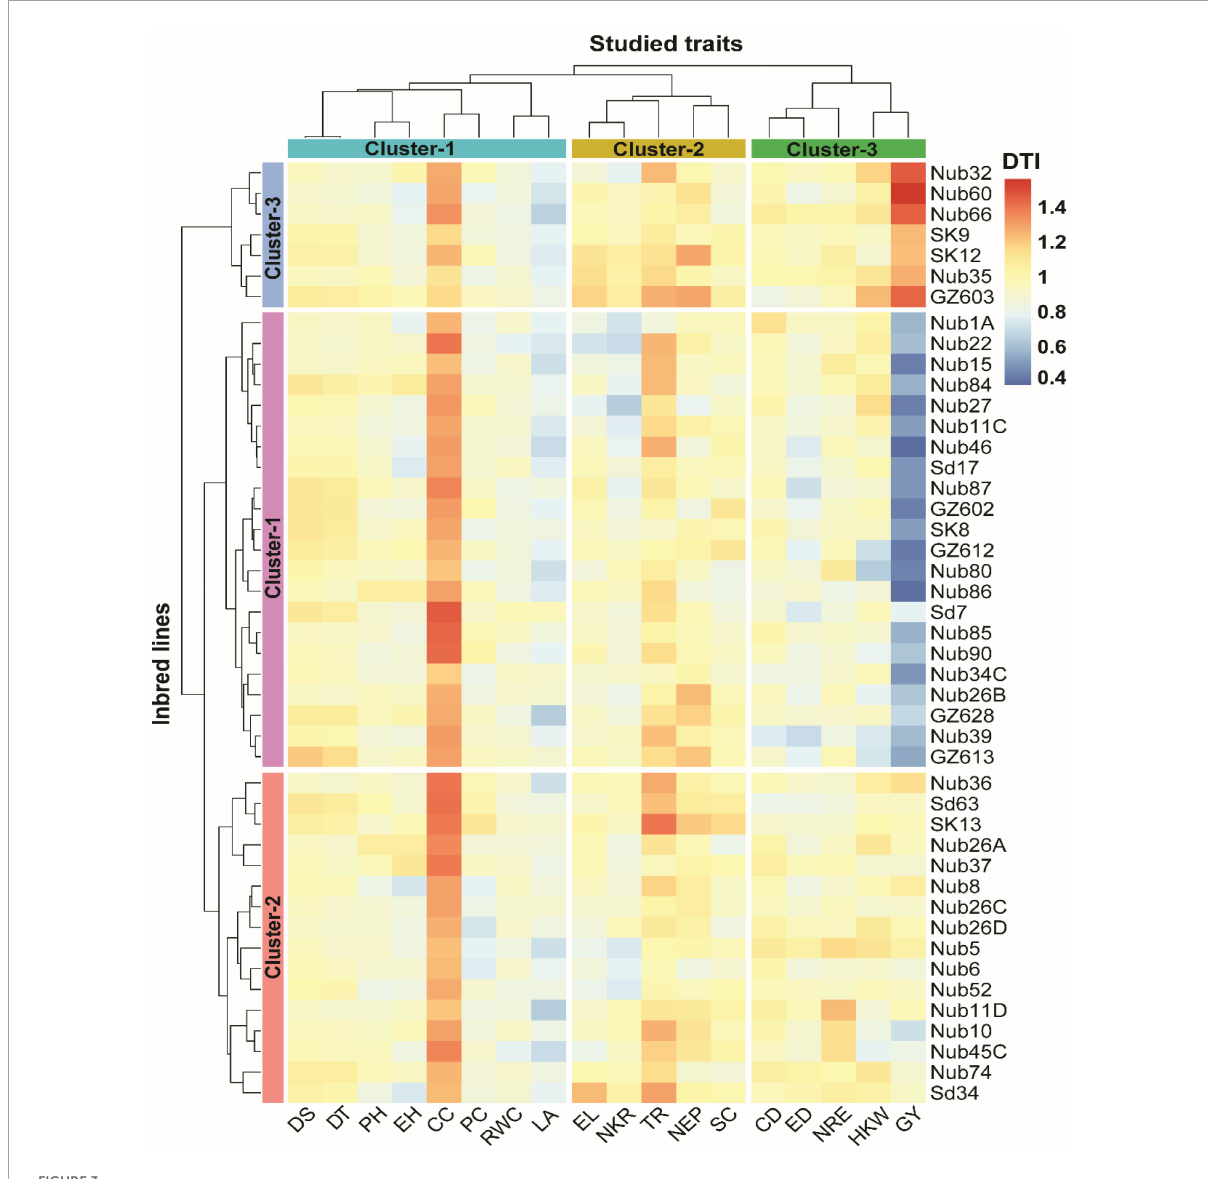
FIGURE3 Hierarchical clustering and heatmap illustrating the associations among 45 maize inbred lines and 18 different traits in respect to drought tolerance index (DTI) condition. The different colors and intensities were adjusted based on cultivars–traits relationships. The darker blue-sky color indicates lower values (drought-sensitive), while the darker red indicates higher values (drought-tolerant). DT, days to 50% tasseling; DS, days to 50% silking; PH, plant height (cm); EH, ear height (cm); NEP, no. of ears/plant; EL, ear length (cm); ED, ear diameter (cm); CD, cob diameter (cm); NRE, no. of row/ear; HKW, 100-kernel weight (g); NKR, number of kernel/row; GY, grain yield (ardbe/fed); LA, leaf area (cm 2 ); RWC, relative water content (%); PC, proline content (mg g - 1 ); CC, chlorophyll content (SPAD); TR, transpiration rate (mmol m - 2 s - 1 ); SC, stomatal conductance (mol m - 2 s - 1